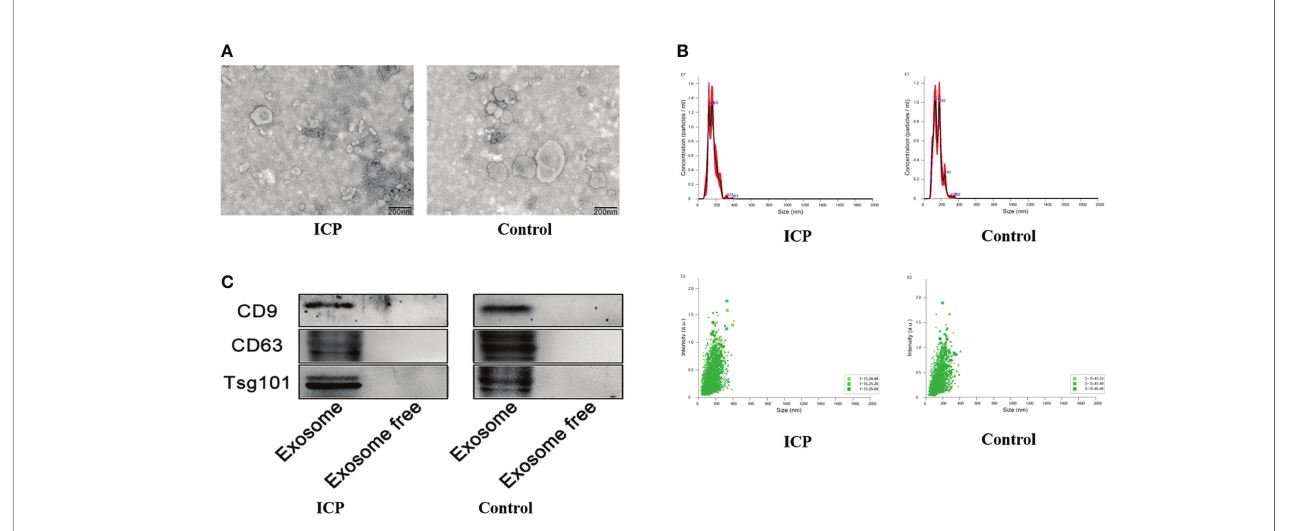
FIGURE 1 | Characterization of serum exosomes extraction. (A) Transmission electron microscopy showing the spherical shape of exosomes. (B) Nanoparticle tracking analysis showing the size distribution and concentration of exosomes. (C) Western blot showing the expression of exosomes protein markers including CD9, CD63, and